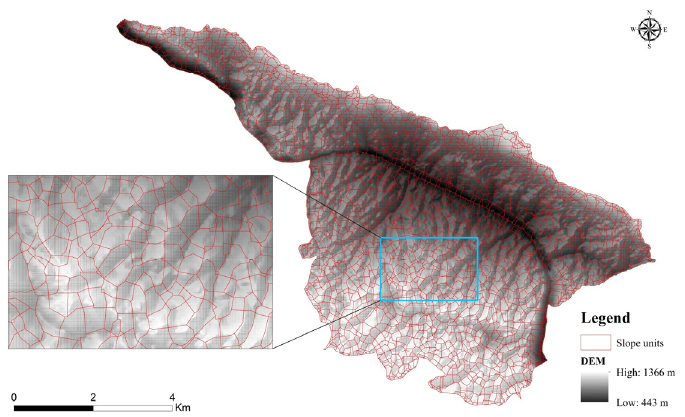
Figure 4. Division of slope units.